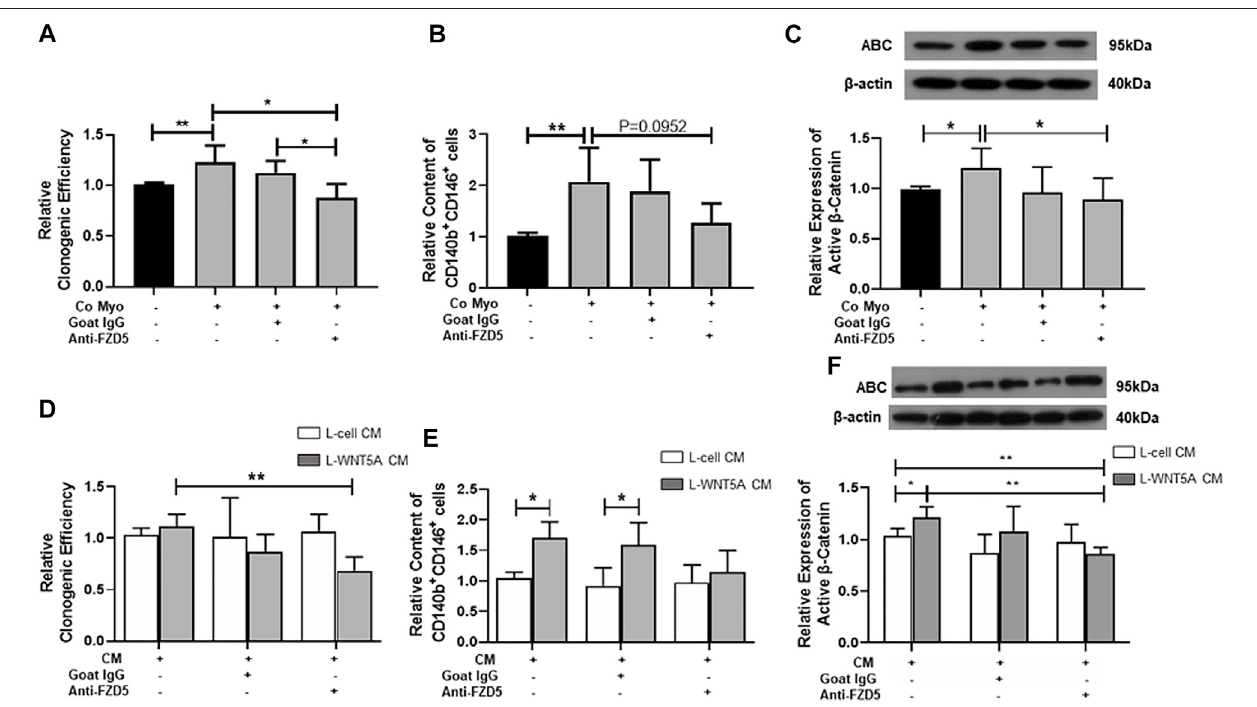
FIGURE 3 | Effect of neutralizing FZD5 on eMSC activities. (A) Relative clonogenic ef fi ciency of eMSC colonies in monoculture (black bars) and coculture with myometrial cells (gray bars) with goat IgG or 1 μ g/ml neutralization FZD5 antibody (n = 5). (B) Relative proportion of CD140b + CD146 + cells after treatment (n = 5). (C) Relative expression of active β -catenin in eMSC in control (black bars) and co-culture with myometrial cells (gray bars) with goat IgG or 1 μ g/ml neutralization FZD5 antibody (n = 7). (D) Relative clonogenicity of eMSC in L-cell CM (white bars) or L-Wnt5a CM (gray bars) with the addition of isotype goat IgG or 1 μ g/ml neutralizationFZD5antibody(n=5). (E) RelativeclonogenicityofeMSC inL-cellCM(whitebars)orL-Wnt5aCM(graybars)withtheadditionofisotypegoat IgGor1 μ g/ mlneutralizationFZD5antibody(n=5). (F) Relativeexpressionofactive β -cateninineMSCinL-cellCM(whitebars)orL-Wnt5aCM(graybars)withtheadditionofisotype goat IgG or 1 μ g/ml neutralization FZD5 antibody (n = 5, normalized to β -actin). Results are presented as mean ± SD, * p < 0.05, ** p < 0.01. Abbreviations: CM, conditioned medium; co myo, co-culture with myometrial cells; eMSC, endometrial mesenchymal stem-like cells; FZD, frizzled.